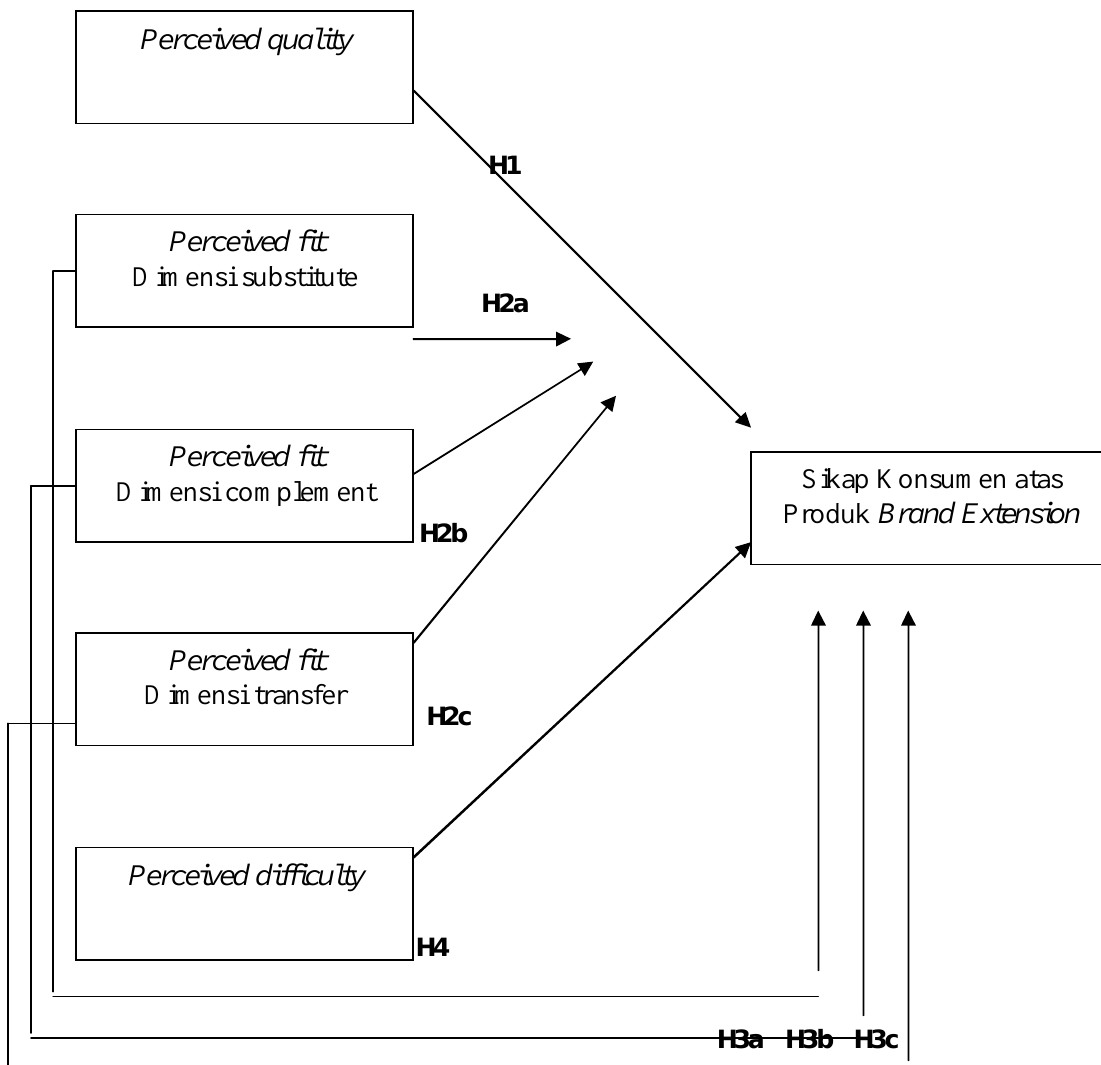
Gambar 1: Model Penelitian